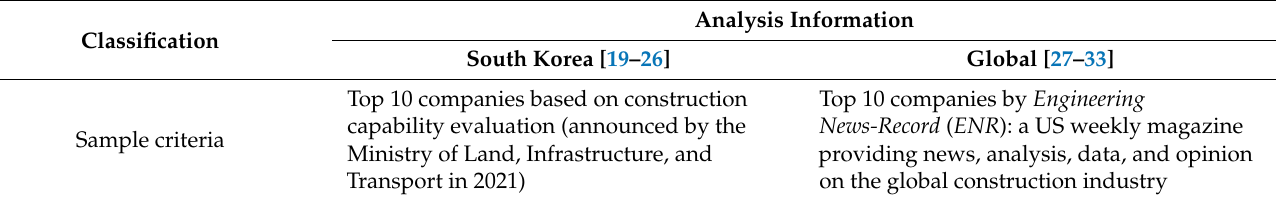
Table 4. Status of analysis